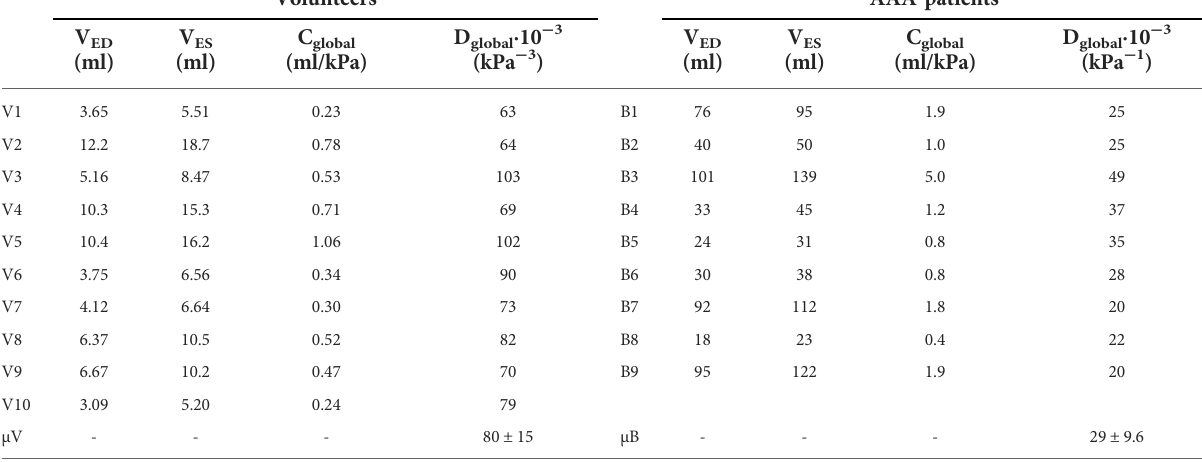
TABLE 4 Overview of global mechanical properties of healthy volunteers (V1 – V10) and AAA patients (B1 – B9). Volunteers